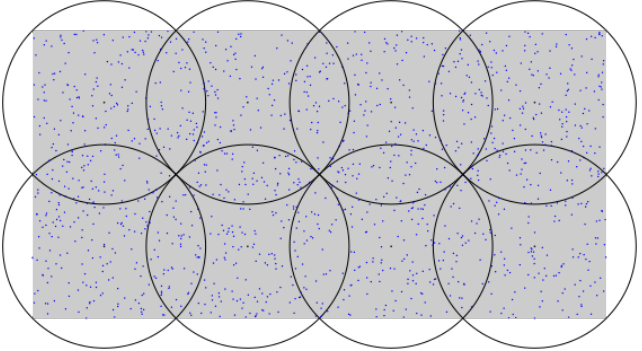
Figure 6. Sample scenario used in the